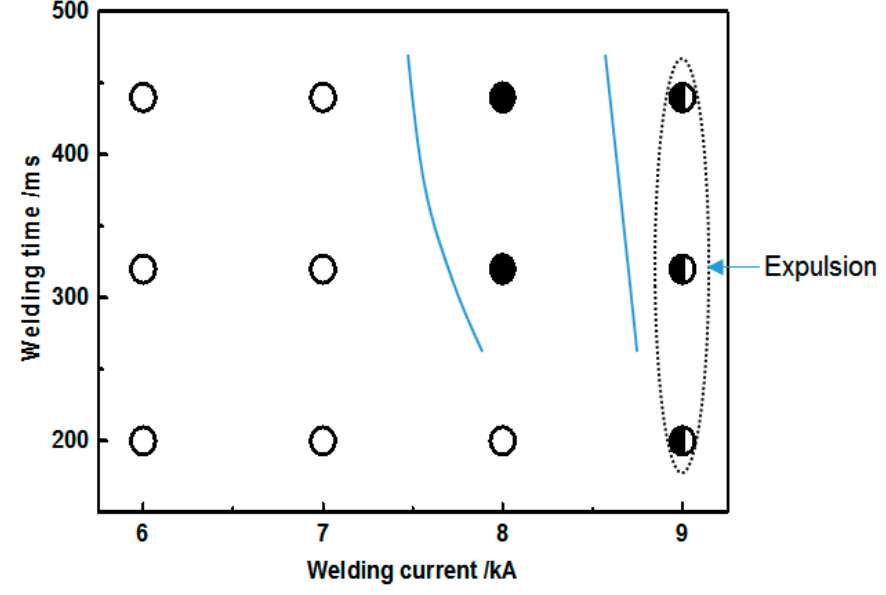
Figure 5. Welding lobes for resistance welding of 1.2 mm thick MS1400 steel.